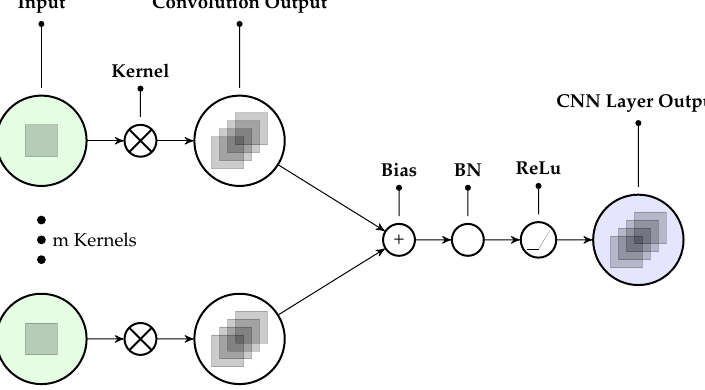
Figure 3. The CNN layer configuration used in the proposed networks. Note, the Bias, batch normalization (BN) and rectified linear unit (ReLu) operations are applied per activation (see Equation